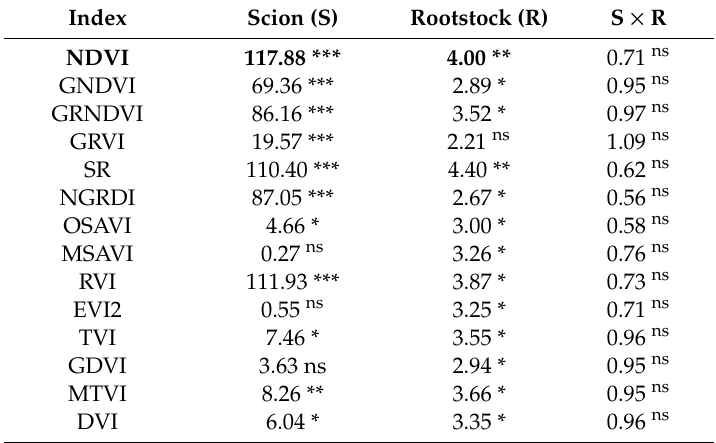
Table 2. ANOVA results (F-value and probability levels) of the 14 vegetation